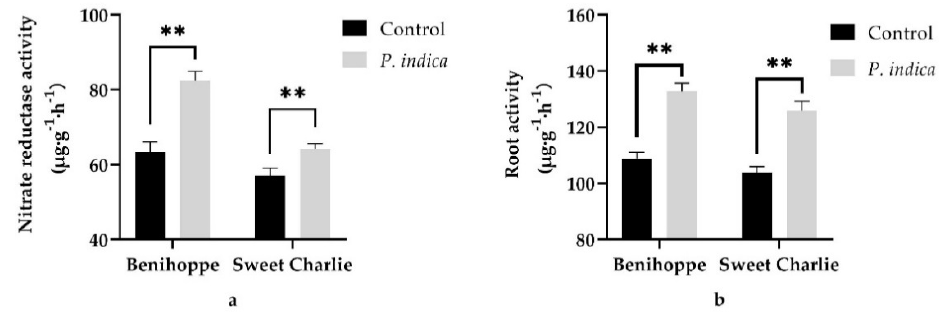
Figure 4. The influences of P. indica on the leaf nitrate reductase activity and root activity of strawberry daughter plants. ( a ) Leaf nitrate reductase activities of P. indica colonized and noncolonized strawberry daughter plants; ( b ) Root activities of P. indica colonized and noncolonized strawberry daughter plants. Values were presented as mean ± SD of three replicates. **, p < 0.01.